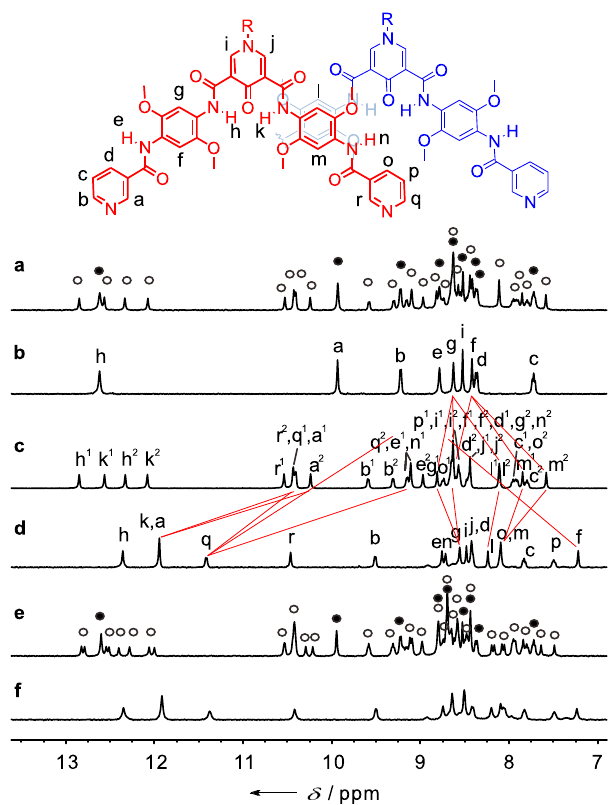
Fig. 2 1 H NMR (600 MHz) spectra of the helicates and the corresponding Cl − complexes in CD 3 CN (500 μ L). a Excerpts of 1 H NMR spectra of mixture of 1 and 2 (ca. [ L ] = 1.8 mM) at equilibrium. b 1 formed from coordination of L and Pd 2 + at low concentration (ca. [ L ] = 0.2 mM). c 2 formed from coordination of L and Pd 2 + at high concentration (ca. [ L ] = 8.0 mM). d Excerpts of 1 H NMR spectra of [2Cl ⊂ 2 ]. e Excerpts of 1 H NMR spectra of 3 S and 4 S (ca. [ L ] = 1.8 mM) at equilibrium. f , Excerpts of 1 H NMR spectra of [2Cl ⊂ 4 S]. The Cl − complexes ( d , f ) were formed by addition of NBu 4 Cl 0.5 mmol to the correspongding helicate solutions ( a , e ), respectively. Amide and aromatic signals of the monomeric helicates and of the dimeric helicates are marked with fi lled and empty circles,